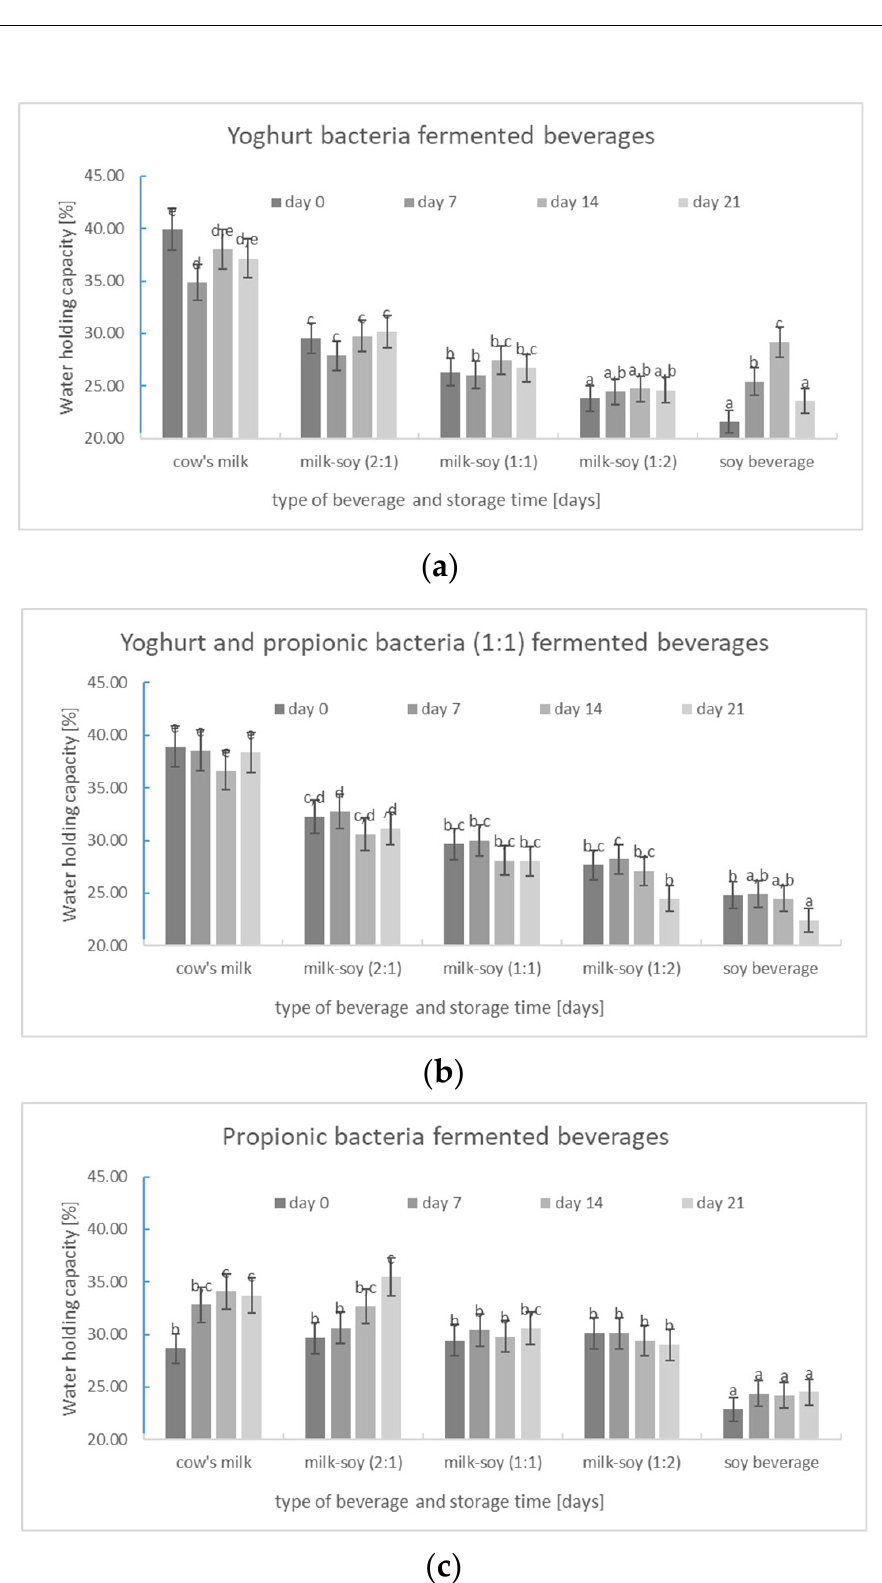
Figure 3. ( a – c ) Changes in water-holding capacity (WHC) of milk, milk–soya, and soya yoghurt products obtained from beverages fermented by different starter cultures and stored at 5 °C for 21 days (mean values and standard deviations). a,b,c,d,e —The same letters on each chart mean there are no statistically significant differences between the compared numerical values ( p < 0.05).